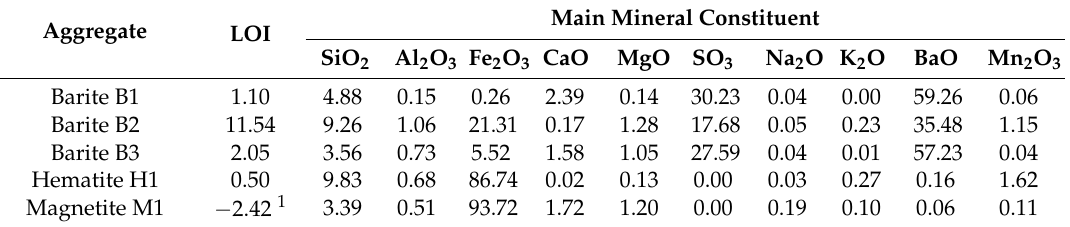
Table 1. Main components of high-density aggregate after X-Ray Fluorescence (XRF) spectroscopy, in % by mass.